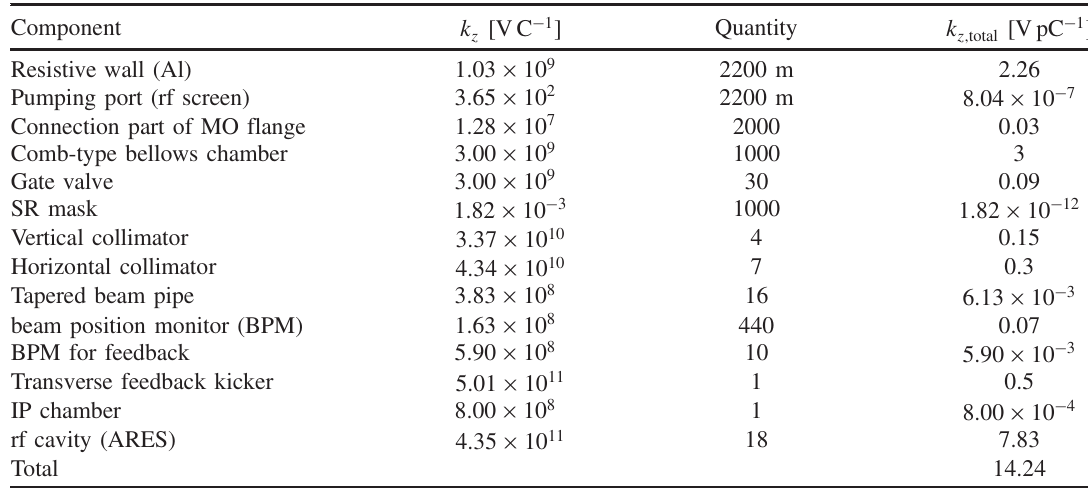
TABLE I. Estimation of loss factor ( k z ) in SuperKEKB LER, calculated with GDFIDL (bunch length: 6 mm). The half apertures in the horizontal and vertical collimator are set to 2 and 5 mm, respectively. The loss factor of the connection part of the MO flange is calculated by assuming a protrusion of 0.2 mm into the beam channel, with a width of 1 mm in the gasket